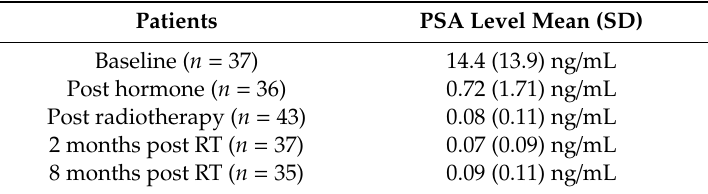
Table 4. Prostate specific antigen (PSA) levels at baseline and at di ff erent treatment